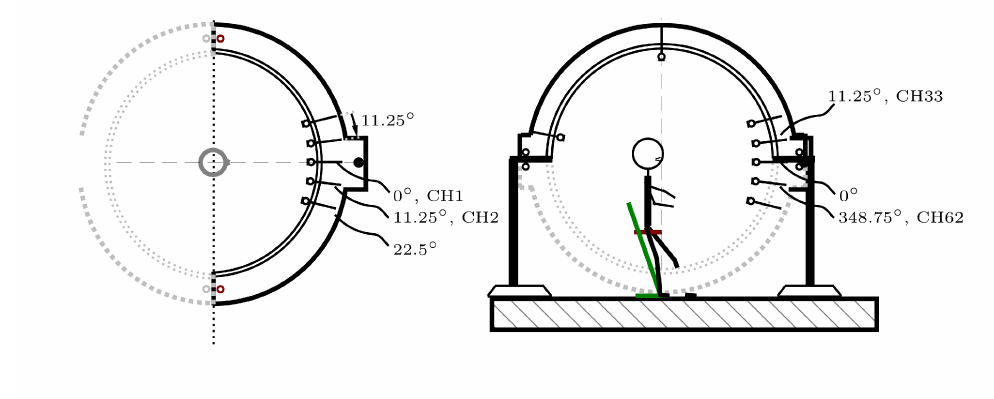
Figure 1. ( Left ): Top view on the microphone array (horizontal plane). ( Right ): Side view on the microphone array (vertical plane). The singer is seated on a chair of adjustable height. Microphone positions and angular spacing are